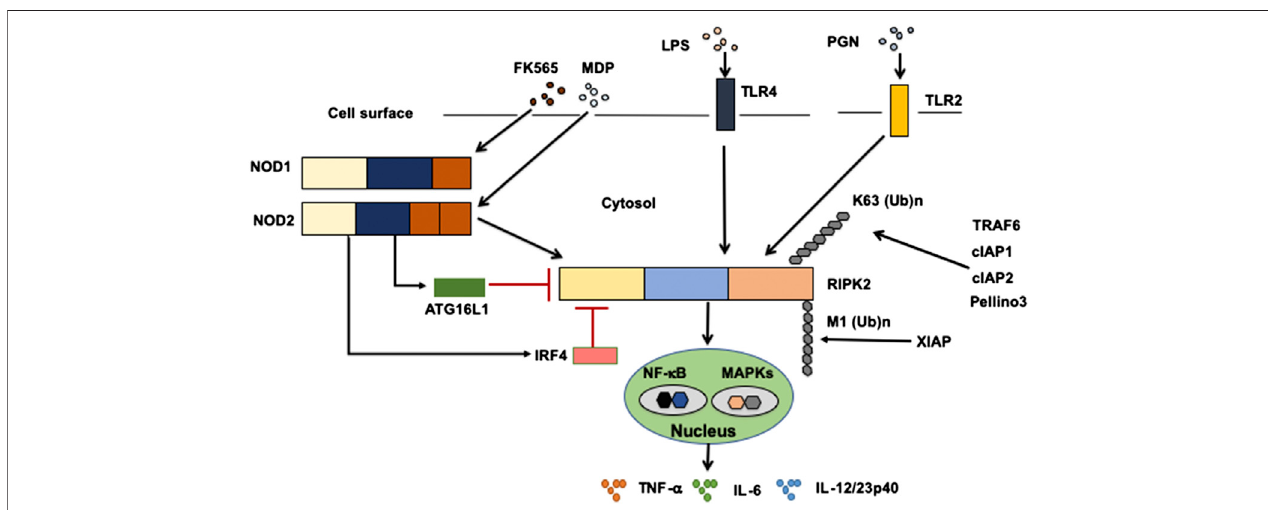
FIGURE 2 | Signaling pathways mediated by RIPK2. Receptor-interacting serine/threonine kinase 2 (RIPK2) is a signaling molecule downstream of nucleotide- binding oligomerization domain 1 (NOD1), NOD2, and Toll-like receptors (TLRs). Activation of RIPK2 by TLRs results in a robust production of pro-in fl ammatory cytokines, including TNF- α , IL-6, and IL-12/23p40, through the nuclear translocation of nuclear factor- κ B (NF- κ B) subunits. Cellular inhibitor of apoptosis protein 1 (cIAP1), cIAP2, TNF receptor-associated factor 6 (TRAF6), Pellino 3 and X-linked inhibitor of apoptosis protein (XIAP) ubiquitinate RIPK2. RIPK2 is subjected to lysine63(K63)-linkedpolyubiquitination byTRAF6, cIAP1, cIAP2, and Pellino3. RIPK2 isalso subjected toN-terminalmethionine (M1)-linked polyubiquitination byXIAP. Interferon regulatory factor 4 (IRF4) and autophagy related 16 like 1 (ATG16L1) negatively regulate RIPK2-mediated pro-in fl ammatory cytokine responses. LPS, lipopolysaccharide; PGN, peptidoglycan, MDP, muramyl dipeptide.